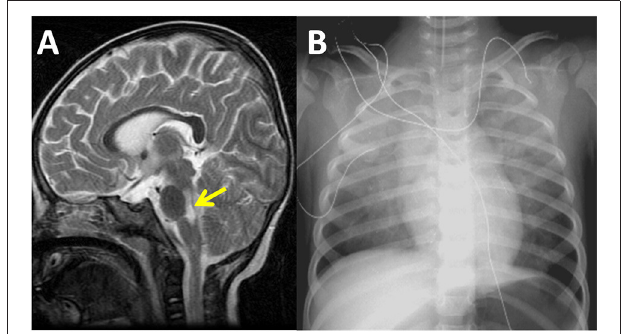
FIGURE 1 | Sagittal magnetic resonance imaging of the brain reveals high signal intensity over the dorsal regions of the brain stem and cervical spinal cord in a 16-month-old patient with severe enterovirus 71 infection and acute heart failure in the year 2001 (A) . Chest radiography demonstrates bilateral pulmonary edema and a normal heart size. The ejection fraction of the left ventricle was 27% as measured by echocardiography at this time (B) .